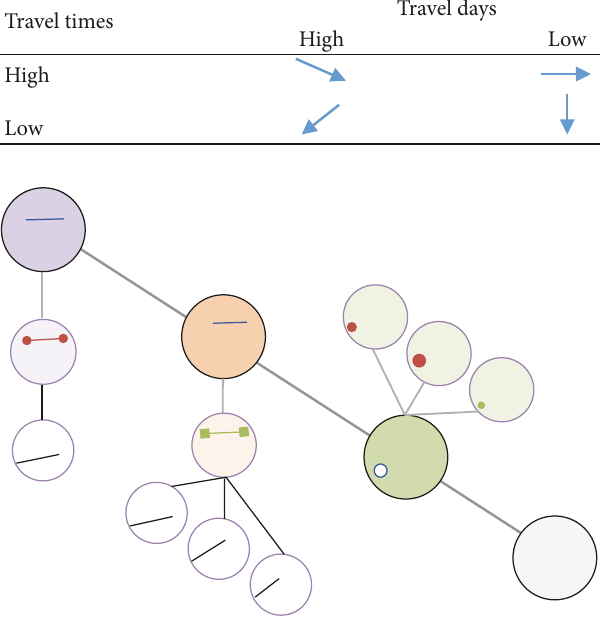
Figure 6: Travel association map integration of P1.